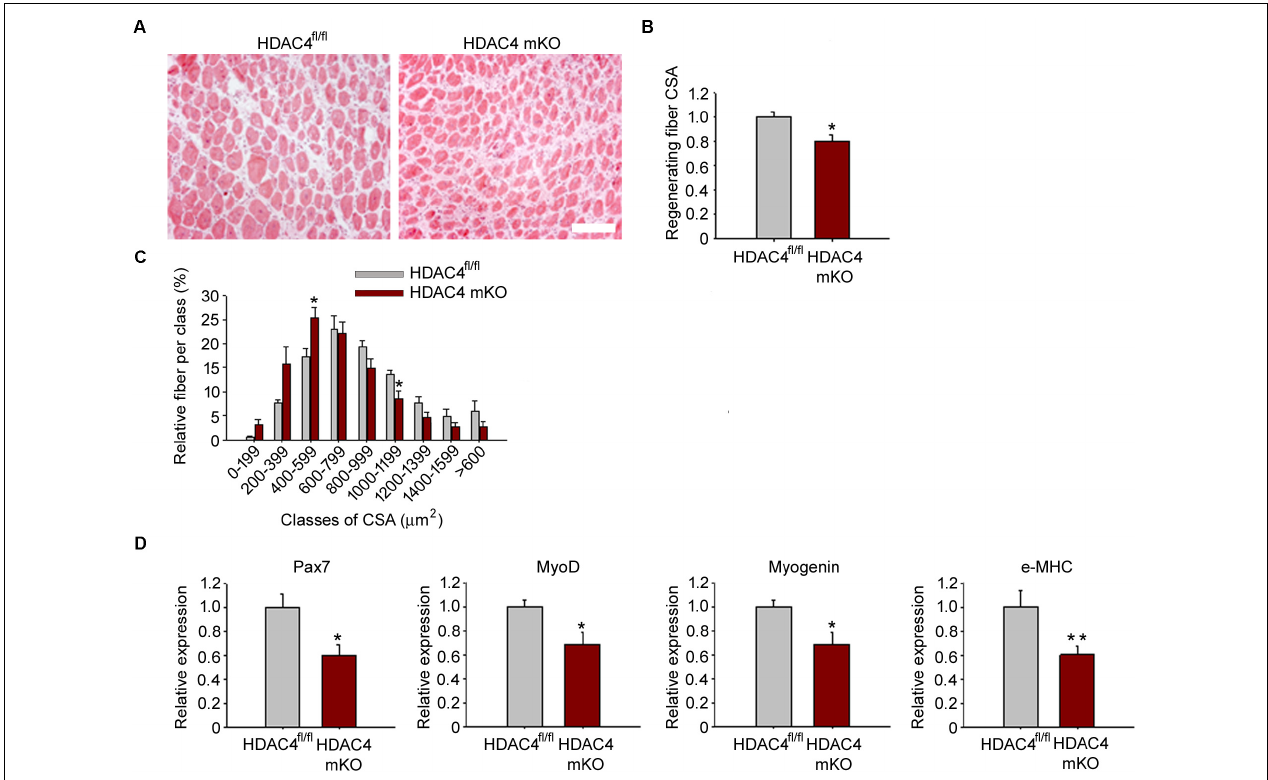
FIGURE 2 | HDAC4 mKO mice exhibit delayed muscle regeneration. (A) Representative images of HDAC4 mKO and HDAC4 fl/fl tibialis anterior regenerating muscles, 1 week after injury. Scale bar = 50 micron. (B) Regenerating fiber CSA of HDAC4 mKO and HDAC4 fl/fl mice, 1 week after injury. Data are presented as median +/ − SEM. n = 8 mice for genotype. ∗ p < 0.05 by Student’s t -test. (C) Morphometric analysis of the distribution of regenerating fiber cross-sectional area, 1 week after injury. n = 8 mice for genotype. Data are presented as average +/- SEM. ∗ p < 0.05 by Student’s t -test. (D) Gene expression of indicated myogenic markers in HDAC4 mKO and HDAC4 fl/fl mice, by real-time PCR, 4 days following injury. Data are presented as mean +/ − SEM. n = 8 mice for genotype. ∗ p < 0.05; ∗∗ p < 0.005 by Student’s t